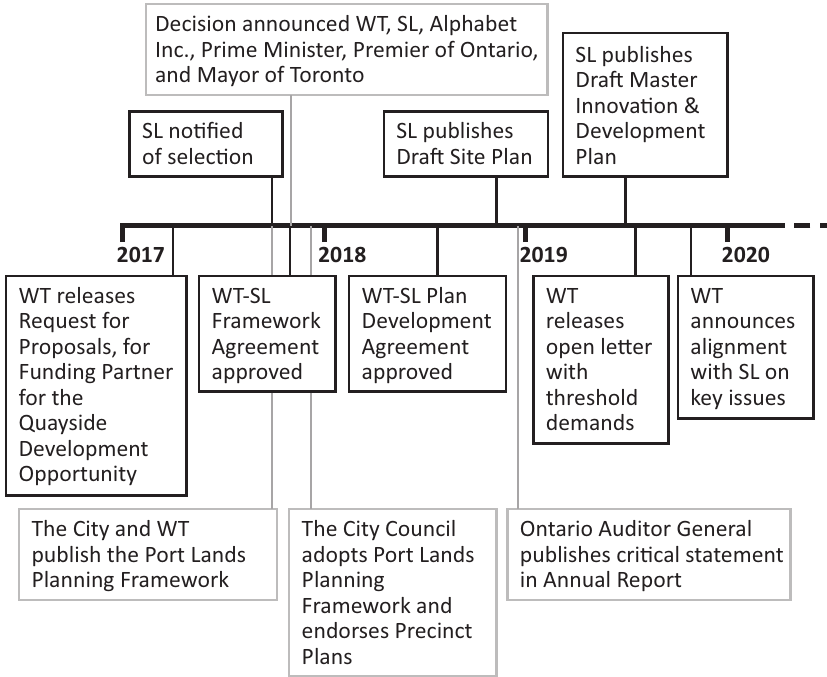
Figure 2. Timeline of key dates and publications concerning the procurement of